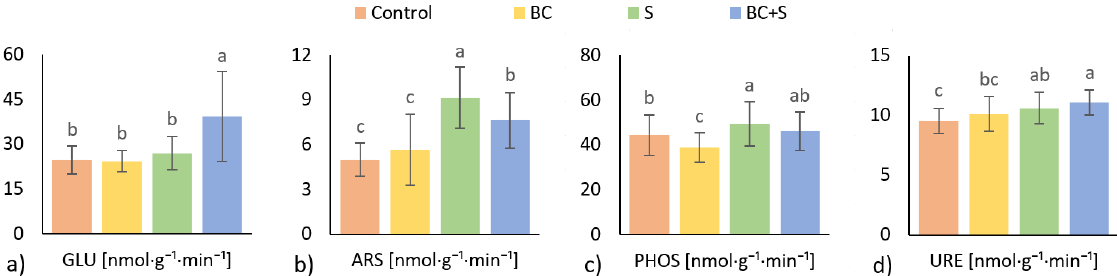
Figure 2. Soil activities of β - glucosidase — GLU ( a ), arylsulfatase — ARS ( b ), phosphatase — PHOS ( c ), and urease — URE ( d ); tested treatments: BC — biochar, S — sulphur, BC + S — biochar and sulphur. Mean ± SD. The different letters express the results of ANOVA Tukey’s HSD Posthoc Test— the statistical differences at significance level p ≤ 0.05.